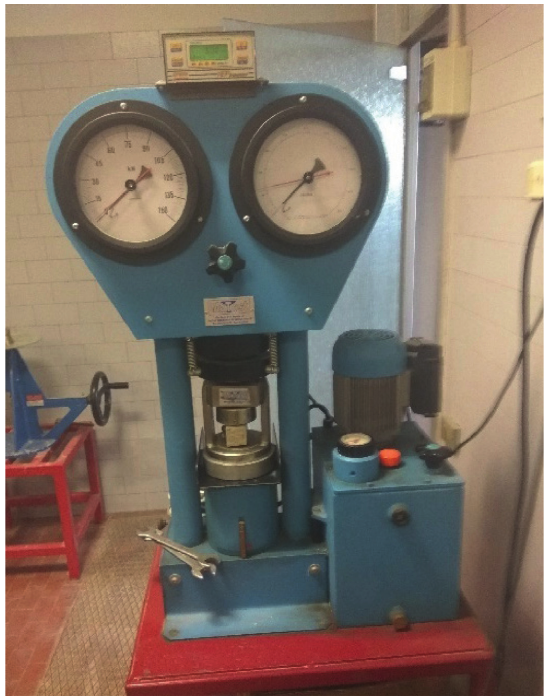
Figure 5: Compressive test on cubic